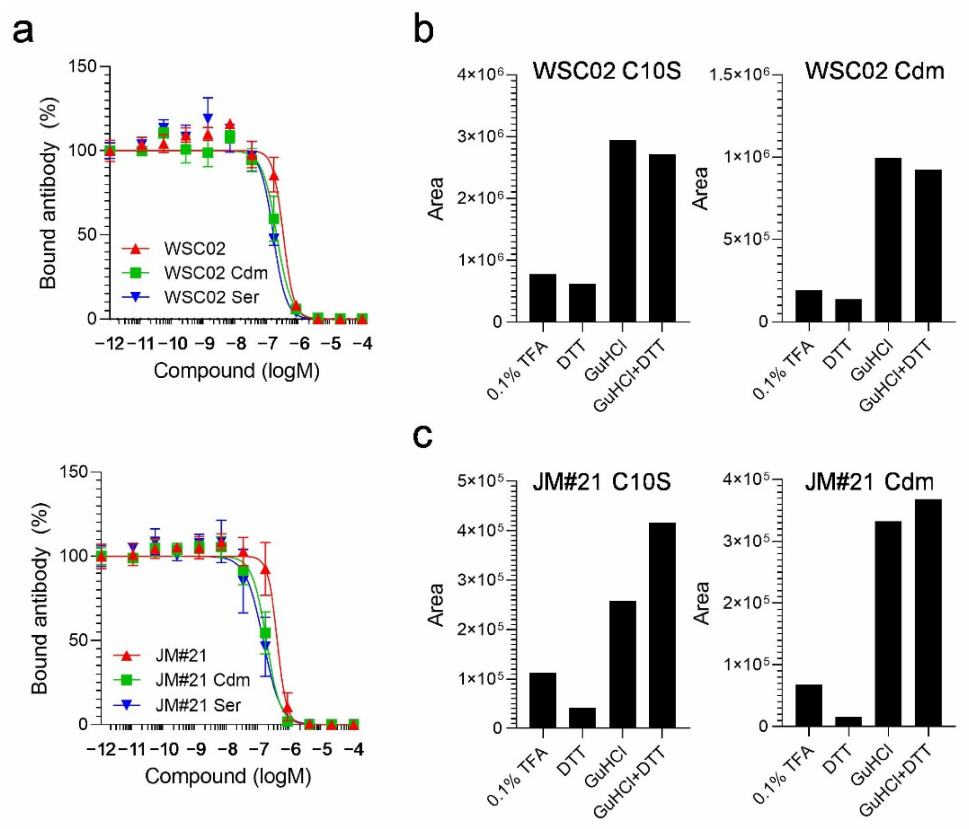
Figure 4. Biological activity and mass spectrometry analysis of thiol-lacking EPI-X4 WSC02 and JM#21 in plasma. Peptides with Cys replaced by Ser (C10S), or with a derivatized Cys (Cdm), are still functionally active and detectable by mass spectrometry in human plasma without previous treatment with reducing or chaotropic agents: ( a ) Peptide variants compete with the CXCR4-specific 12G5-antibody. Data from three individual experiments ± SEM are shown; ( b , c ) variants of WSC02 ( b ) or JM#21 ( c ) were incubated in human plasma for 10 min at 37 ◦ C, and then treated with either 0.1% TFA, DTT, GuHCl, or a combination of GuHCl and DTT. Later, the samples were analyzed by mass spectrometry for the detection of peptide derivatives. The area values in ( b ) and ( c ) are calculated from the corresponding peak in the MS extracted ion chromatogram of every